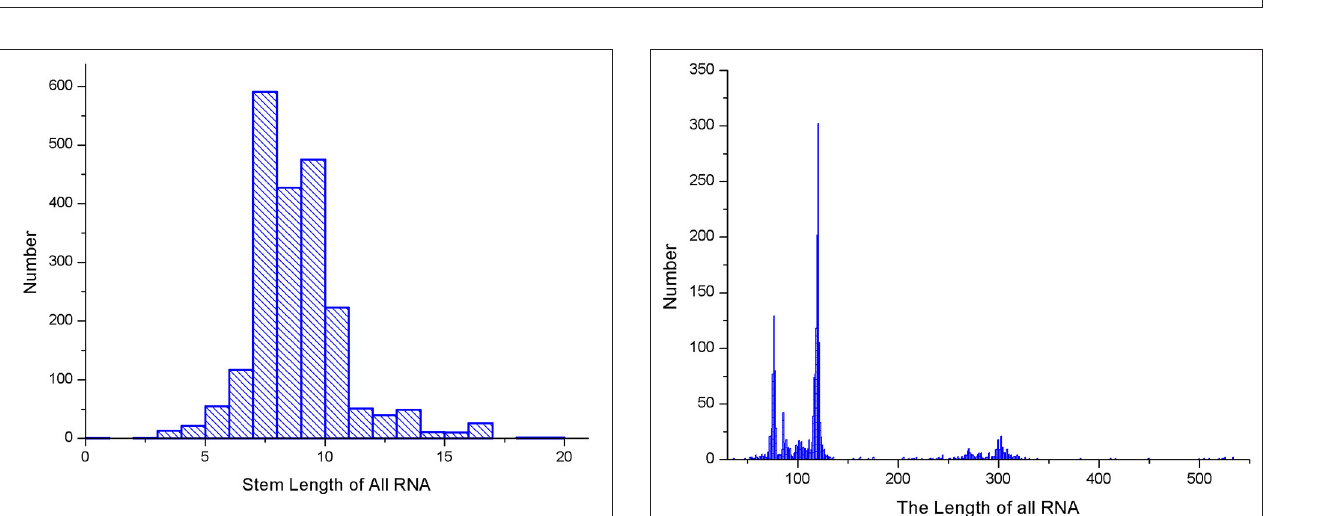
FIGURE 8 | Number and length distribution of the RNA data of each family after redundancy.